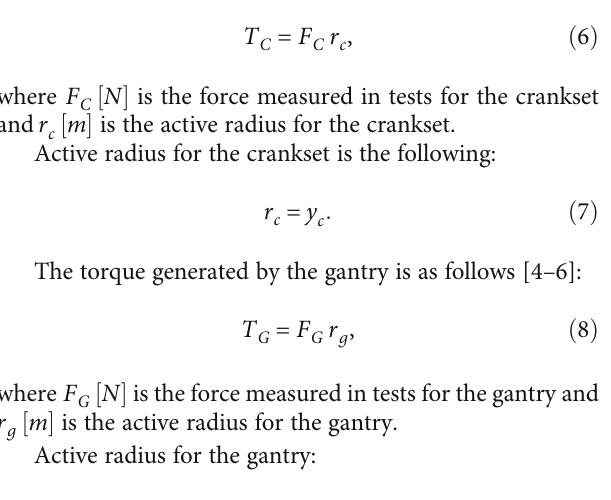
Angle Position number γ [ °